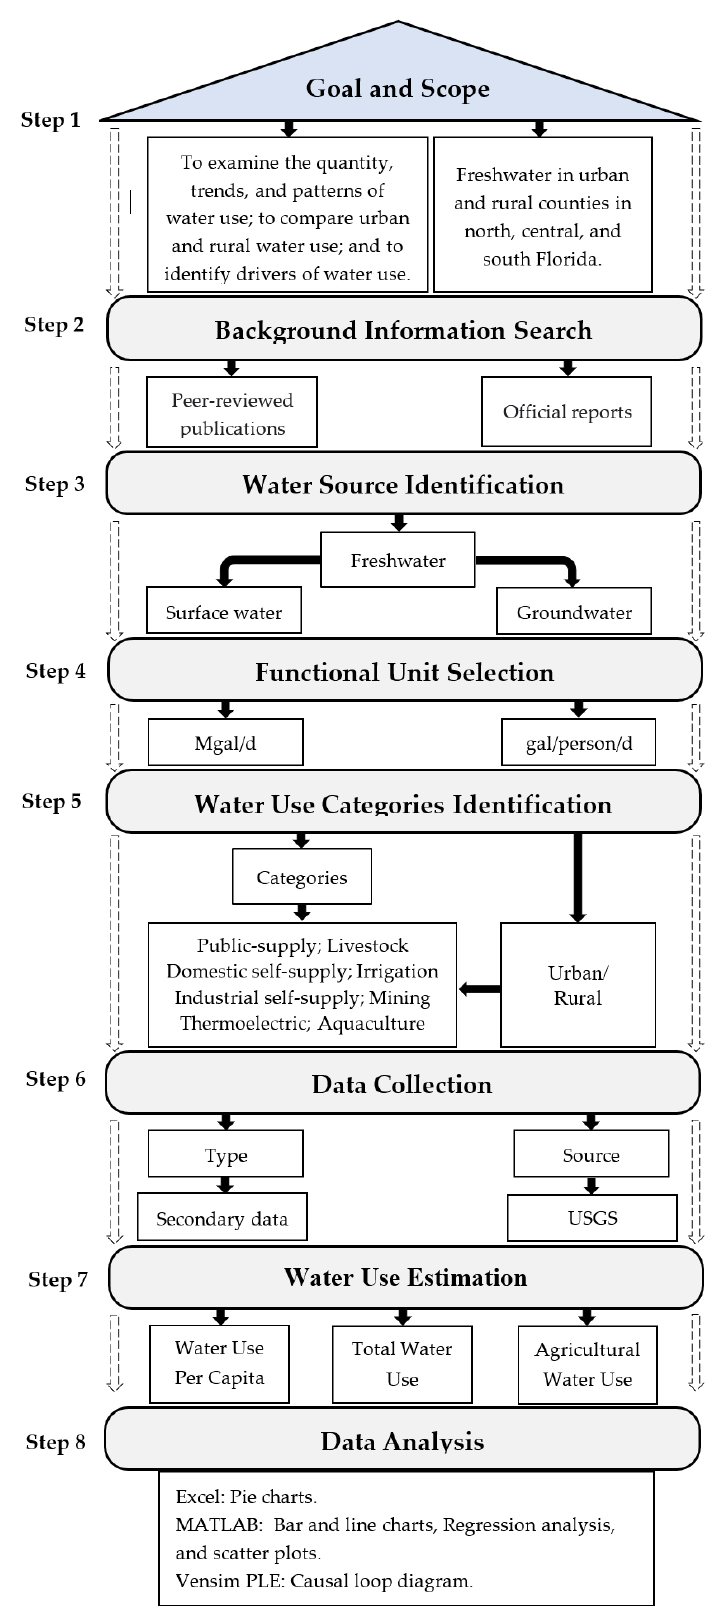
Figure 2. Flowchart showing the methodology. The dotted arrows show the sequence of steps in the methodology. The solid arrows indicate the elements considered at each stage.